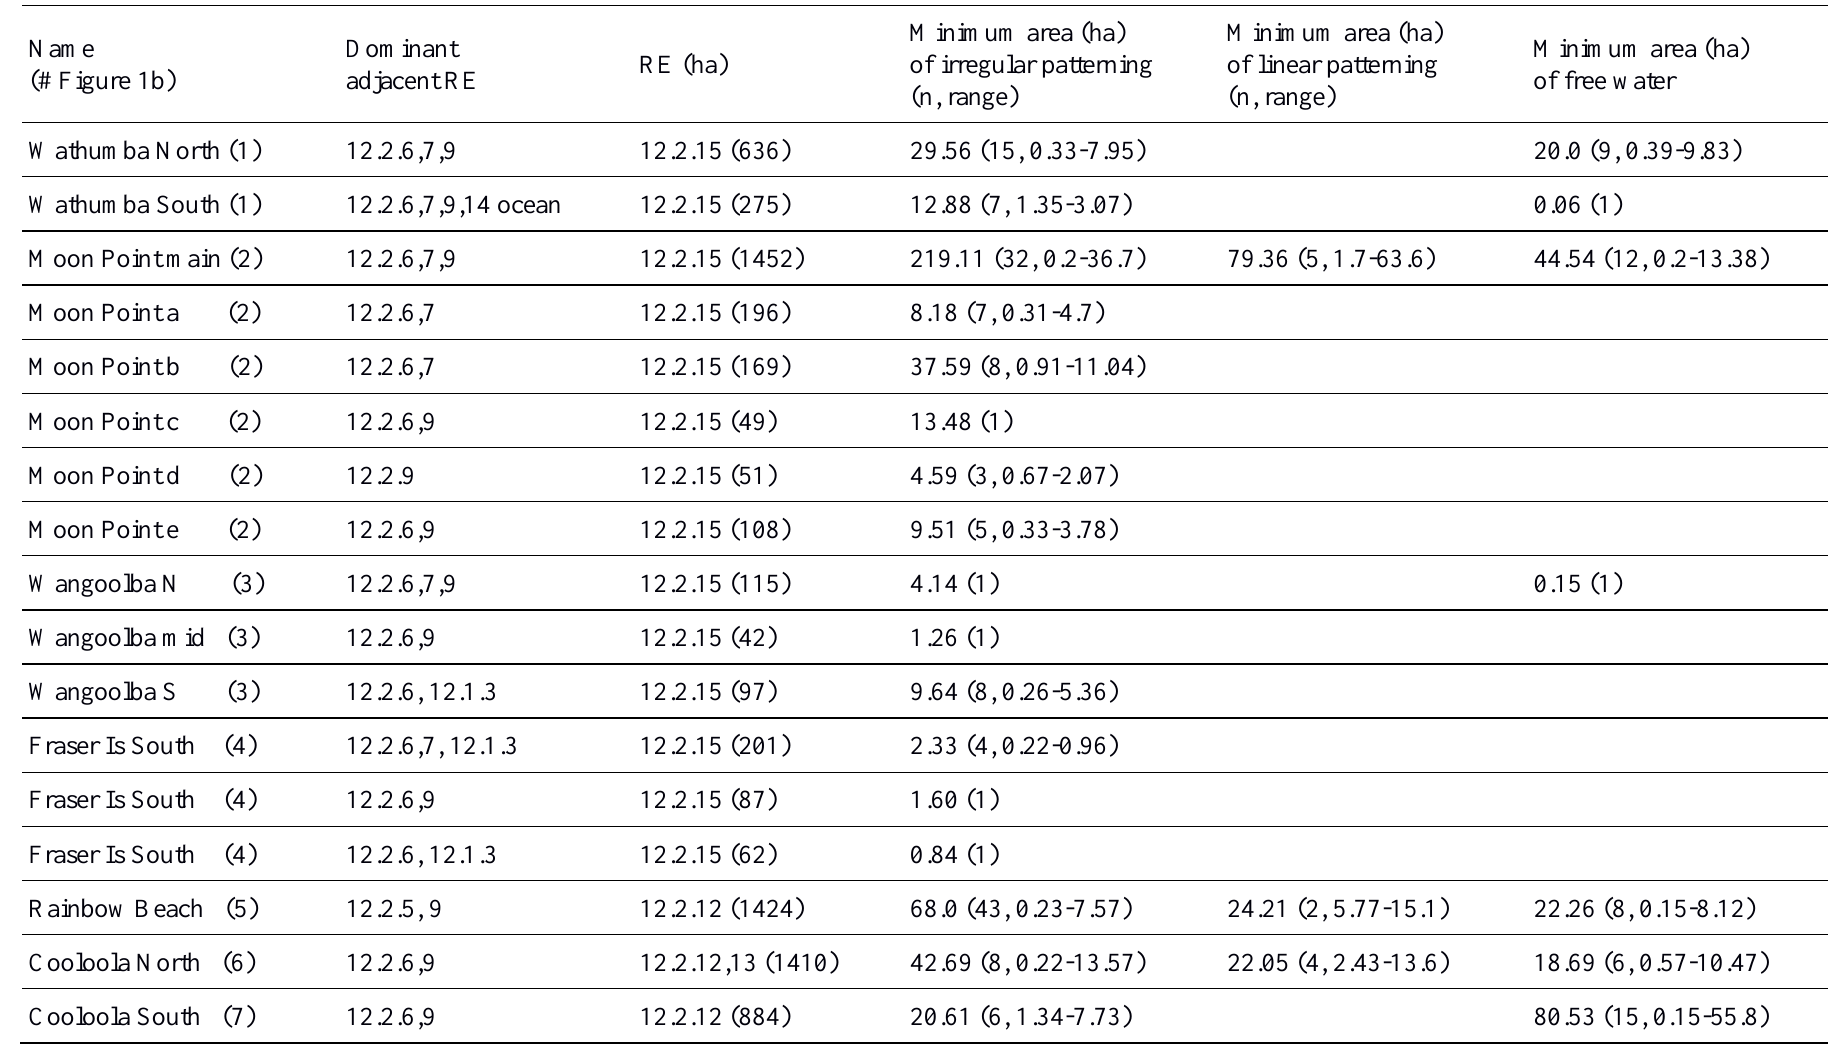
Table 1. Areal extent (ha) of: wet heath vegetation containing patterned fens of the GSR as illustrated in Figure 1c (RE = Regional Ecosystem, Queensland Herbarium 2019) and the minimum area of irregular/reticulate patterning, linear patterning and open pools without surface vegetation (illustrated in Figures 2 and